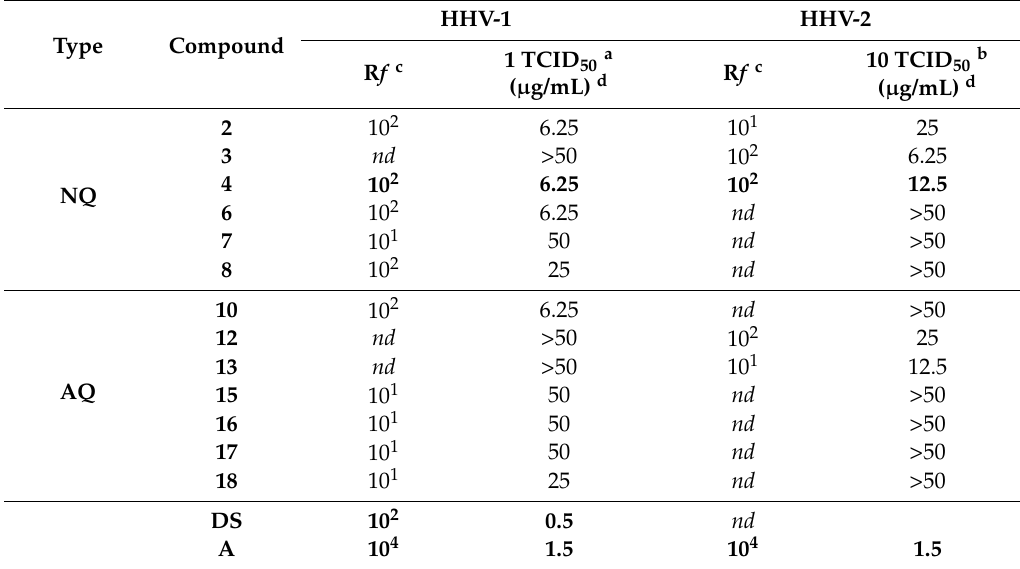
Table 2. Reduction of viral titer and antiviral activity against Human Herpesvirus type 1 (HHV-1) and 2 (HHV-2) on infected Vero cells of selected 1,4-naphthoquinones (NQ) and 1,4-anthraquinones